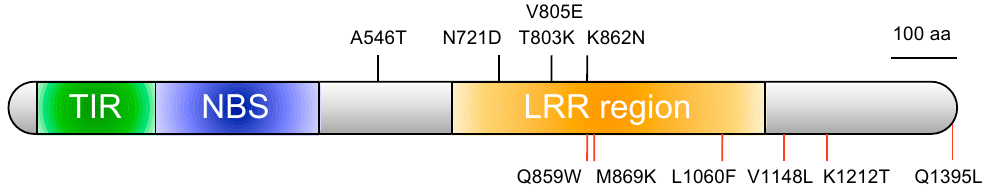
Figure 3. Protein structure of FocBr1 in the resistant line of B. rapa . TIR (green box), NBS (blue box), and LRR region (orange box) were identified. Black lines represent the position of difference of amino acid sequences between resistant and susceptible lines in B. rapa , while amino acid sequences of FocBr1 in the susceptible lines were identical to the FocBo1 ( Foc resistance gene in B. oleracea ). Red lines represent the position of susceptible line-specific amino acid substitutions. Domains were predicted using HMMSCAN with Pfam database. (https://www.ebi.ac.uk/Tools/hmmer/, accessed on 1 April 2021) and NCBI conserved domain search (https://www.ncbi.nlm.nih.gov/Structure/cdd/wrpsb.cgi, accessed on 1 April